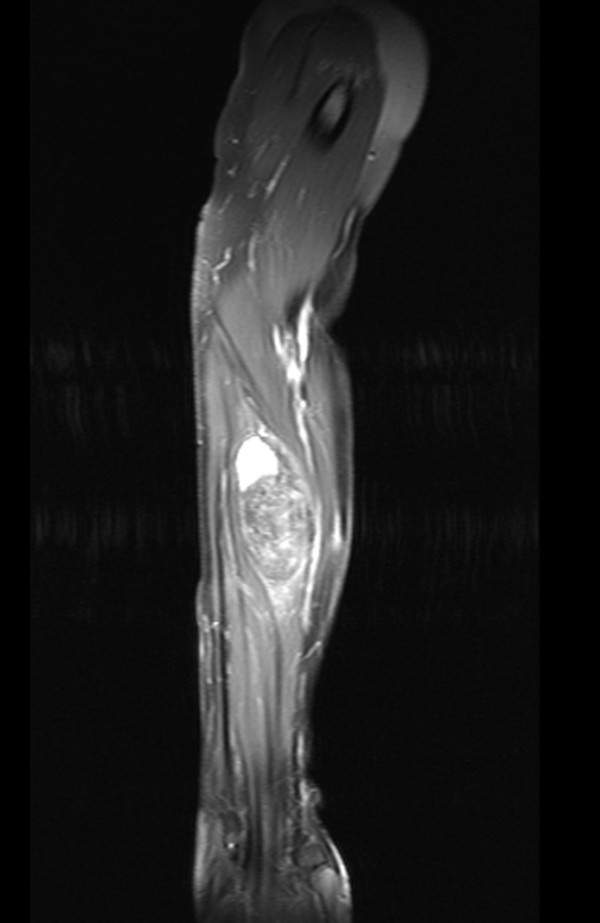
MRI of SFT. MRI of a solitary fibrous tumor depicting a relatively well circumscribed soft tissue tumor in the forearm.